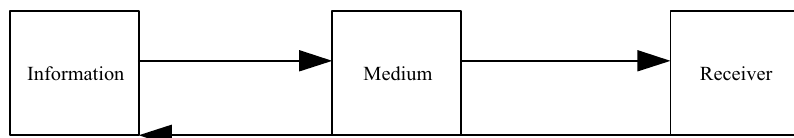
Figure 1: Color emotion information recognition